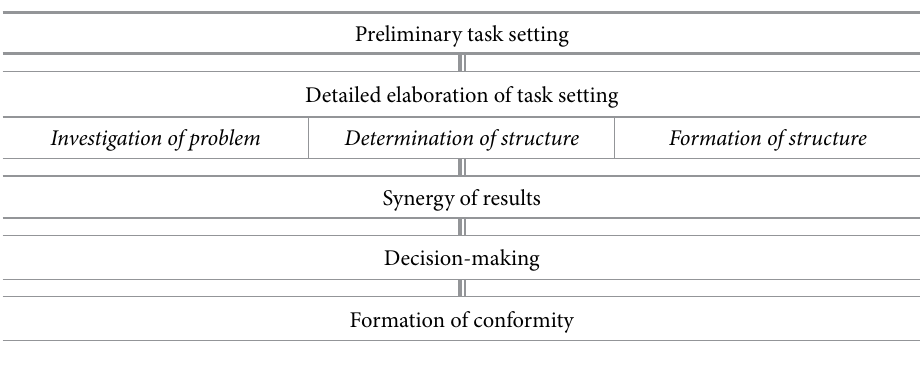
fig. 2. The enlarged scheme of the MBP